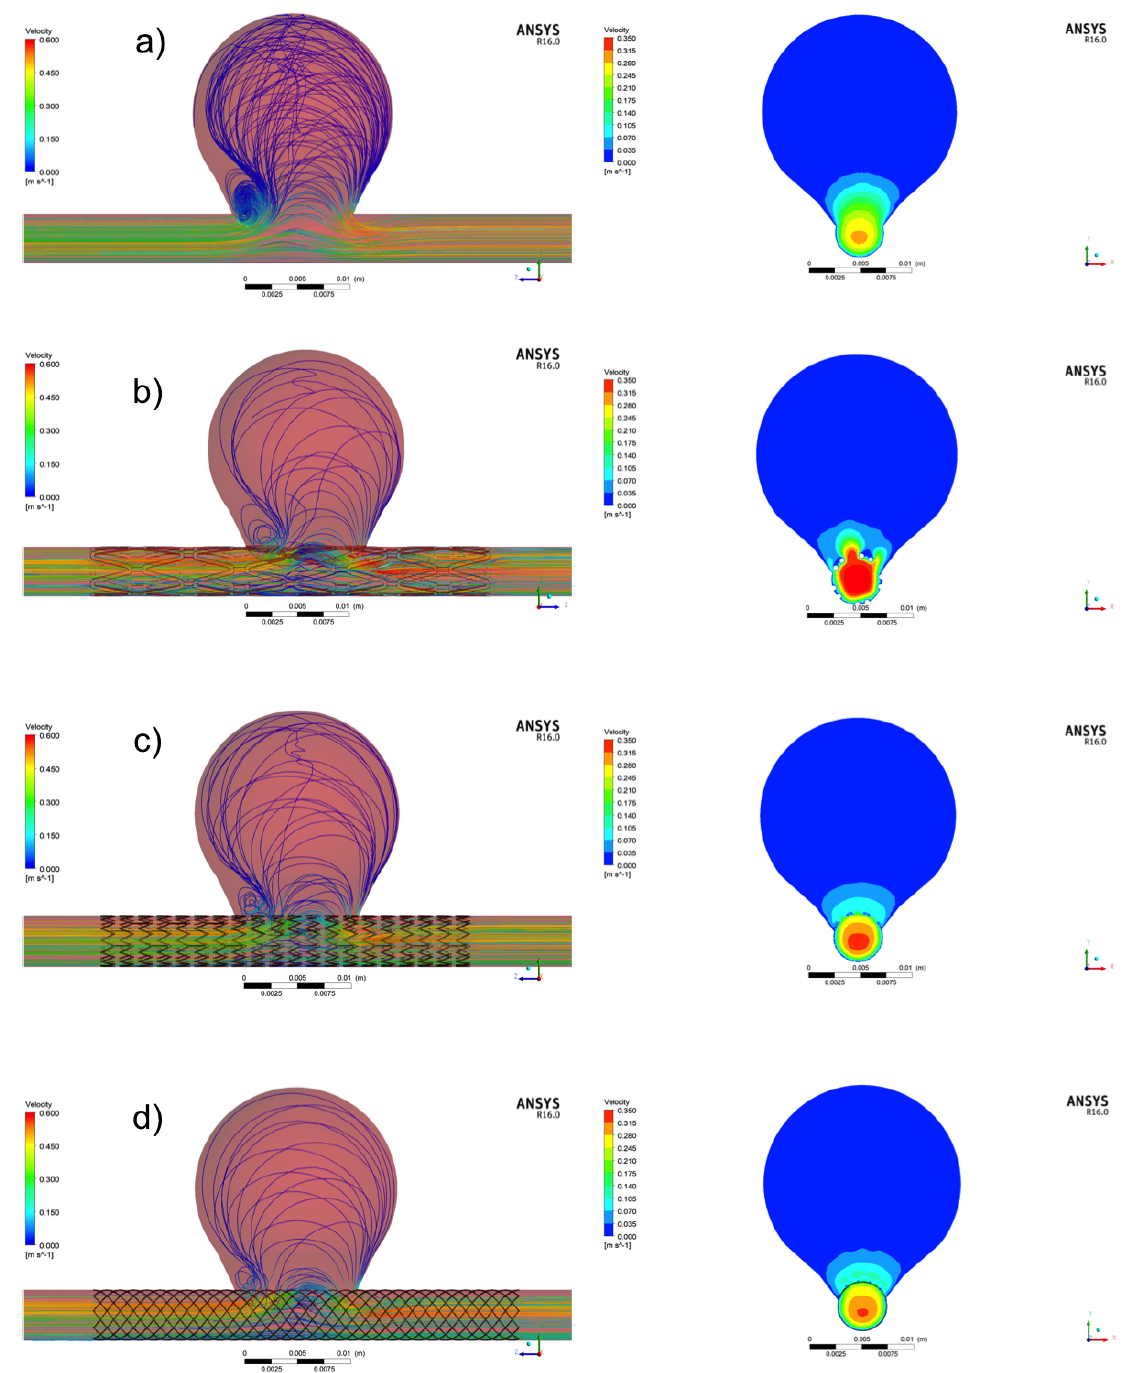
Figure 4. On the left are the streamlines emitted from inlet and neck colored with the local velocity magnitude, on the right are the velocity magnitude depicted on a transverse plane; for the cases of ( a ) control case, ( b ) STENT BS, ( c ) STENT 1, and ( d ) STENT